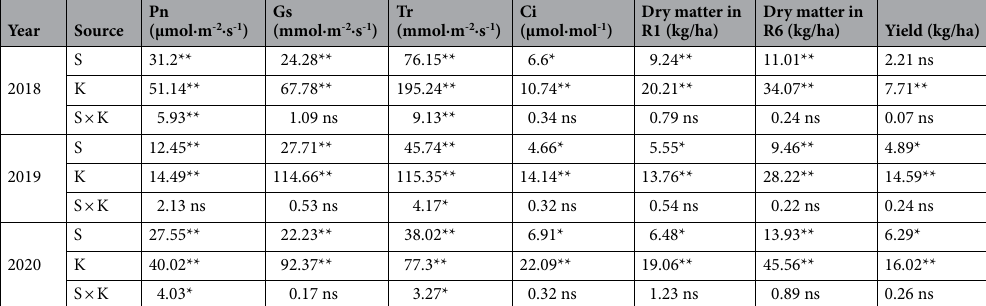
Table 3. Significance of the effects of straw return methods, potassium fertilization levels and their interactions on maize growth and yield using ANOVA. Numbers were F-values. Stars indicated the level of significance (* = p < 0.05, ** = p < 0.01), ns represented insignificant. S represented straw return methods, including SF and FG; K represented potassium fertilization levels, including K0, K30, K45, K60 kg/ha.